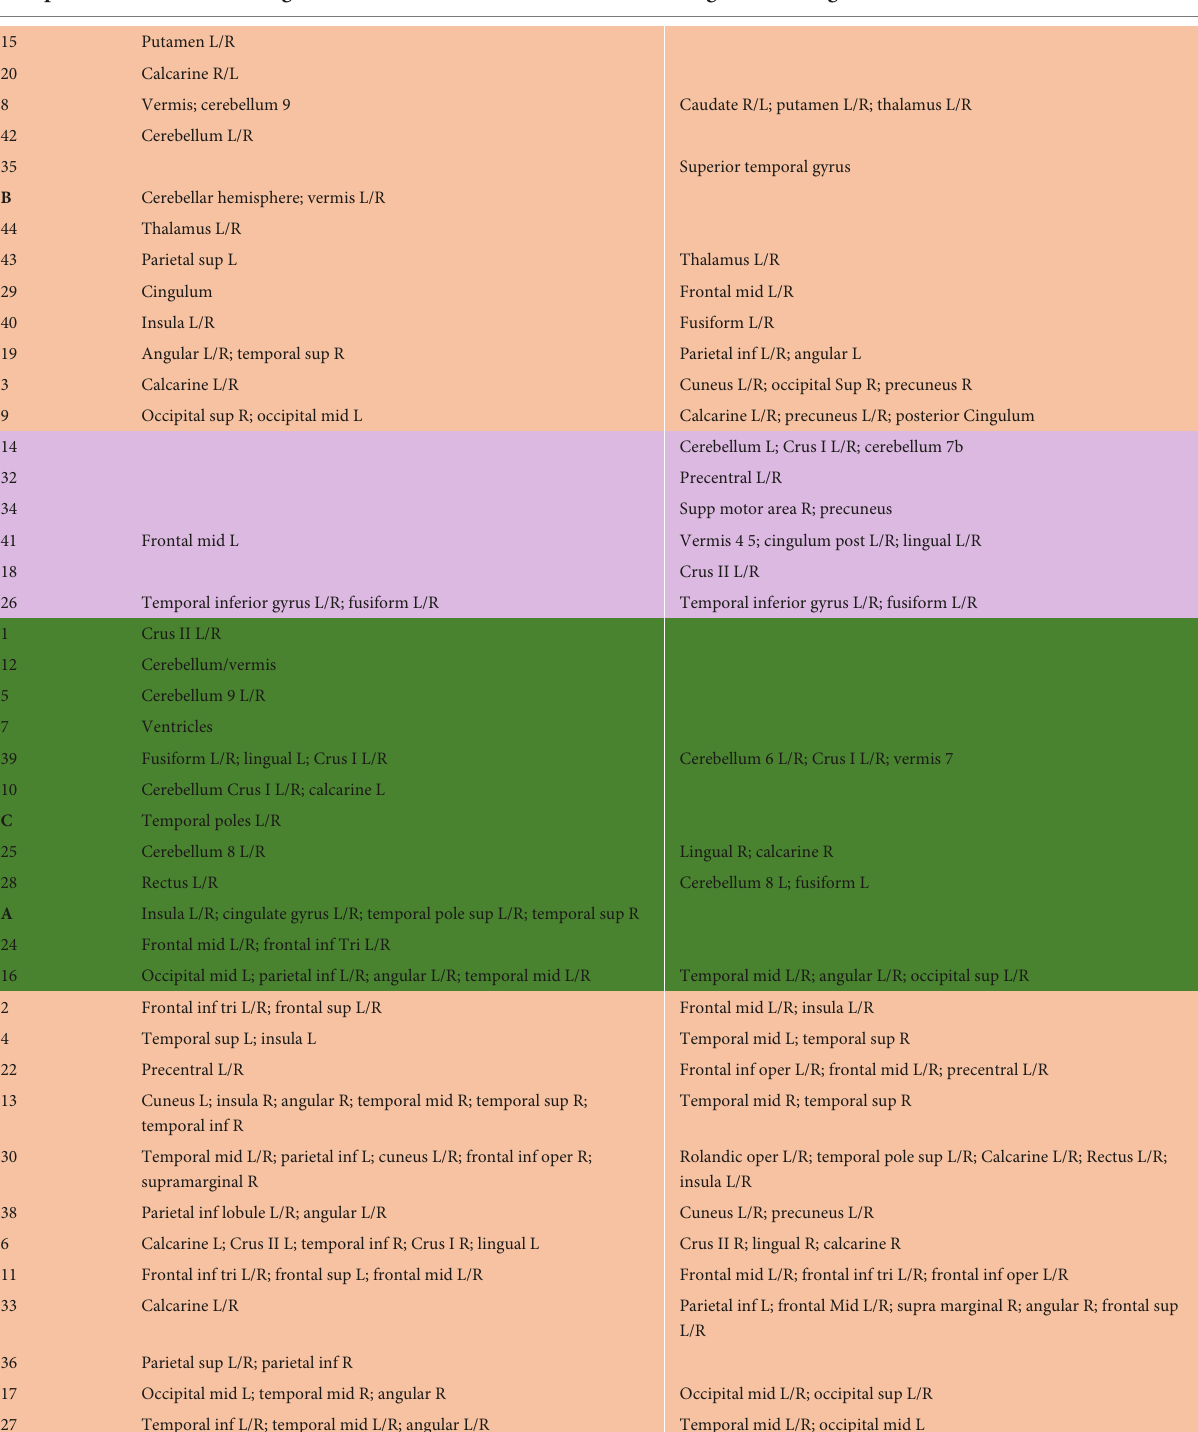
TableisinmatchingordertothehierarchicalclusteringoftheICAdepictedin Figure5 .Thecolorseparationshowsthefour(4)clustersofthehierarchicalcluster(tan,purple,green,and